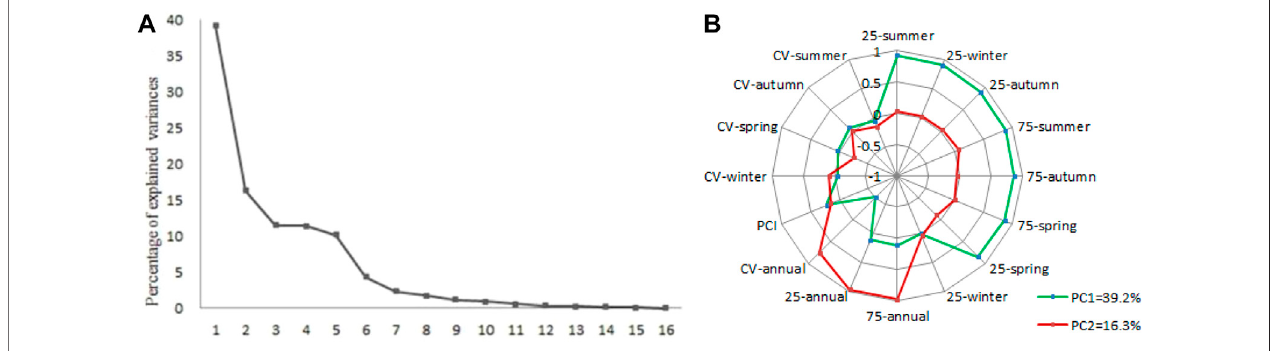
FIGURE 3 | Principal Component analysis (PCA) graphs (A : Line chart of eigenvalues. B : Loading diagram of the fi rst two principal components )